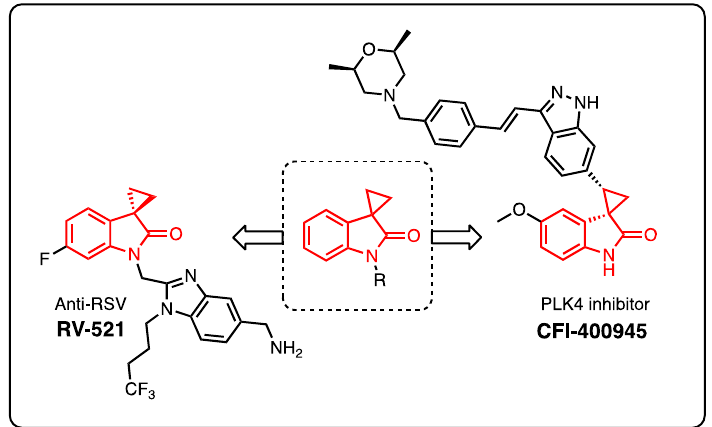
Figure 1. Examples of reported bioactive SCOs.